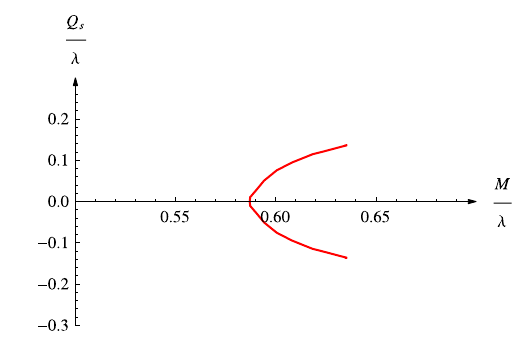
Fig. 7 Two different graphs of scalar charge Q s /λ vs M /λ for the n = 0 black hole with r + = 1 . 174. The M /λ -axis represents the unsta- ble Schwarzschild black hole for 0 < M /λ < 0 . 587 and and the stable Schwarzschild black hole for M /λ > 0 . 587 [12]. (Left) exponential